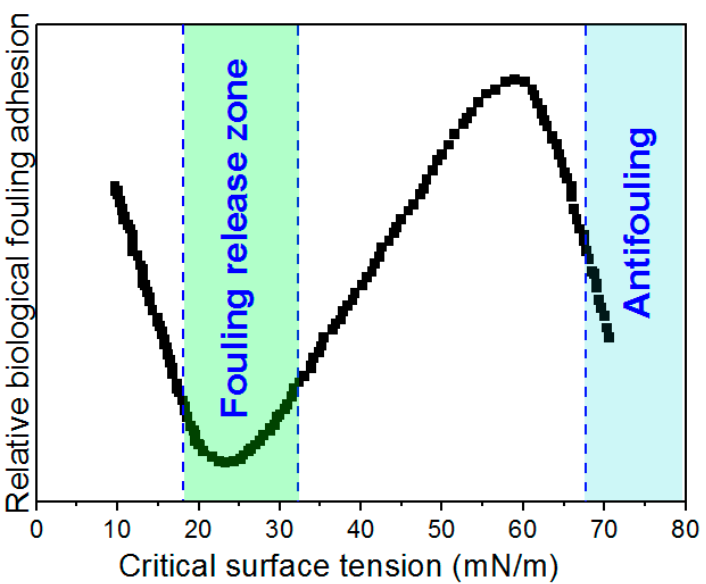
Figure 1. A Baier curve plotting the degree of fouling versus critical surface tension (Adapted with permission from [17]).